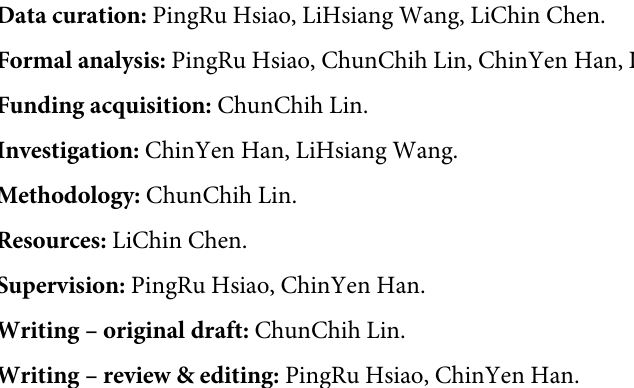
S2 Table. Participants’ demographic